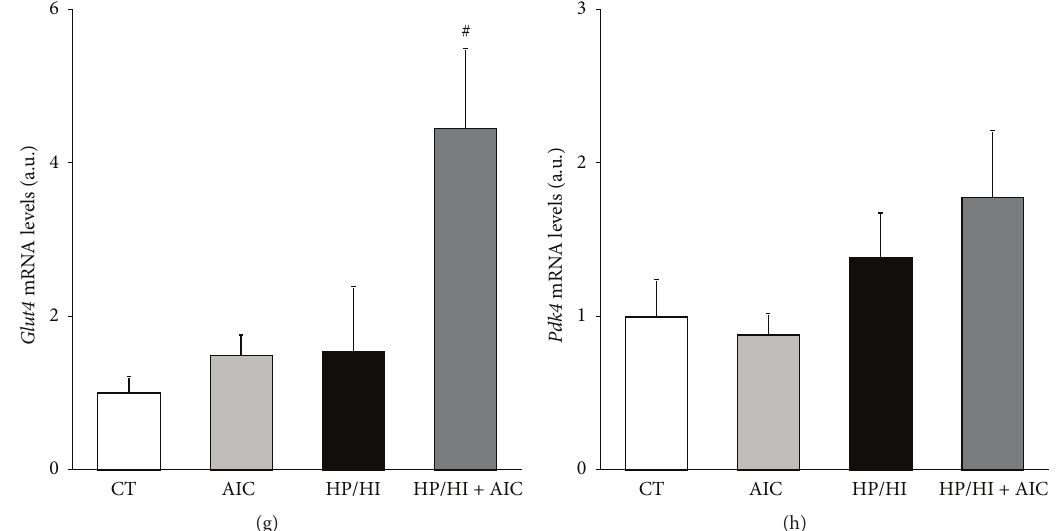
Figure 3: Treatment with AICAR regulates the expression of PPAR-target genes. Analysis of the mRNA levels of Cd36 (a), Acot1 (b), Cpt-1b (c), Acox1 (d), Acadvl (e), Ucp3 (f), Glut4 (f), and Pdk4 (h) by real-time RT-PCR in HL-1 cells stimulated with HP/HI for 16h in the presence or absence of AICAR (24h). Data are normalized by the Cyclophilin A mRNA levels and expressed as mean ± SD of 4 different experiments. ( ∗ 𝑃 < 0.05 , ∗∗ 𝑃 < 0.01 versus control nonstimulated cells; # 𝑃 < 0.05 , ## 𝑃 < 0.01 versus HP/HI-stimulated